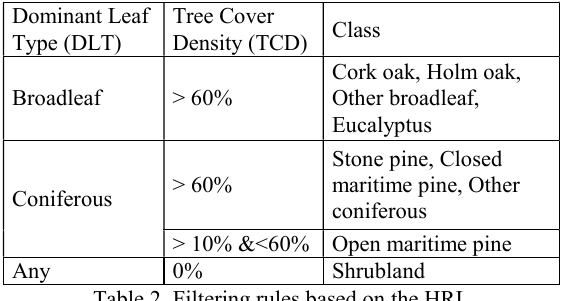
Table 2. Filtering rules based on the